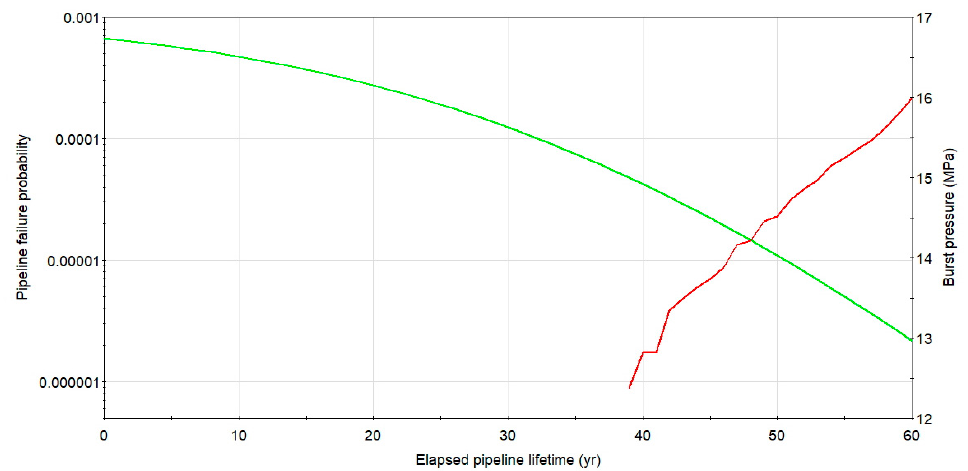
Figure 10. Change of burst pressure and failure probability with time X52 DN 700 MOP = 5.5 MPa